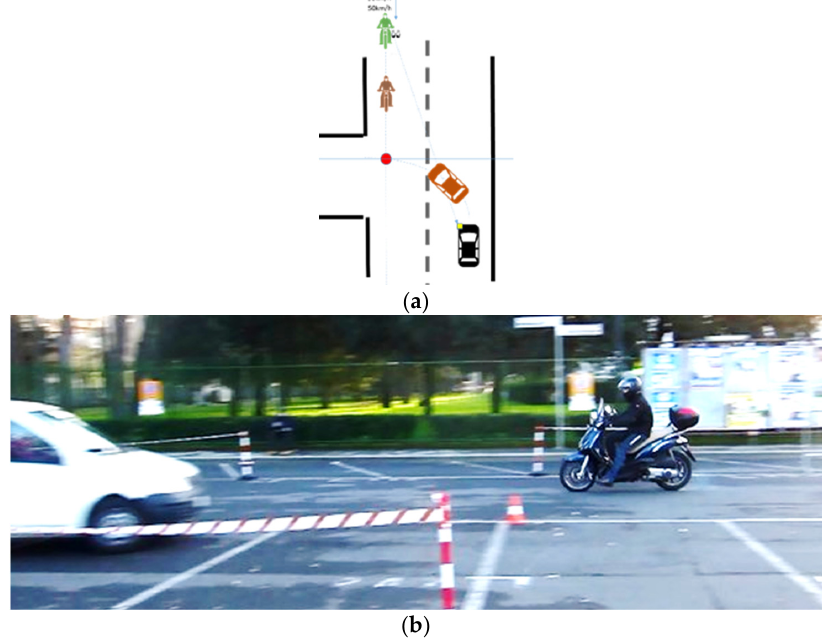
Figure 1. ( a ) Mock intersection; ( b ) Trial with car initiating a LTAP/OD maneuver.